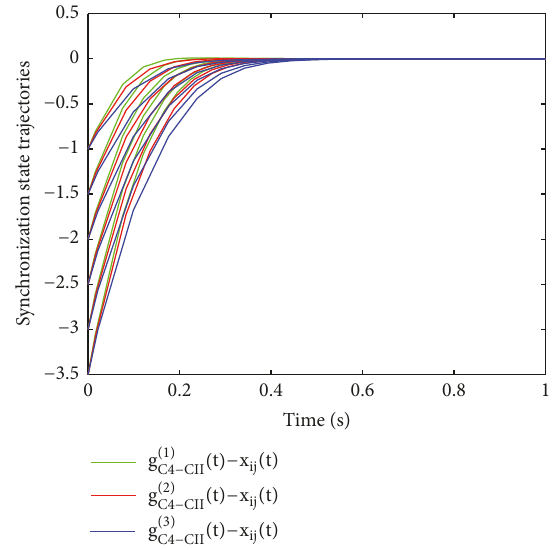
Figure 5: Synchronization state trajectories of the network (36) for the case I of Corollary 21.